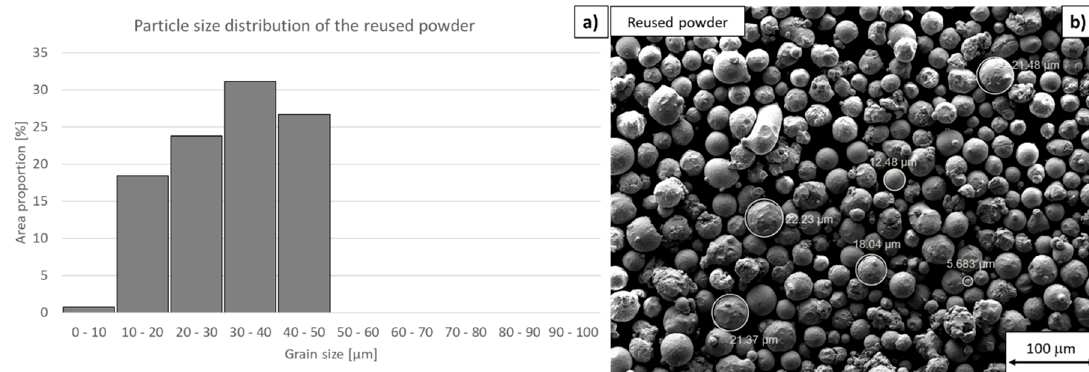
Figure 8. Reused powder. ( a ) Particle size distribution (using ImageJ software, 130 particles were measured for statistical significance), ( b ) tentative particle size measurement in SE micrograph using SmartTiff software.